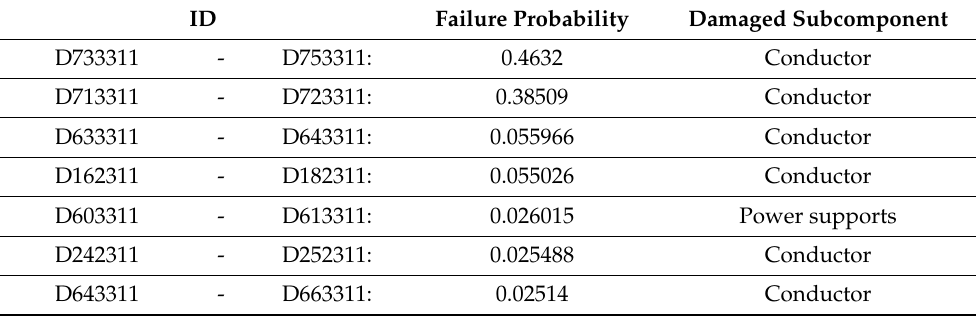
Table 5. List of critical components with failure probabilities over 10 min, case